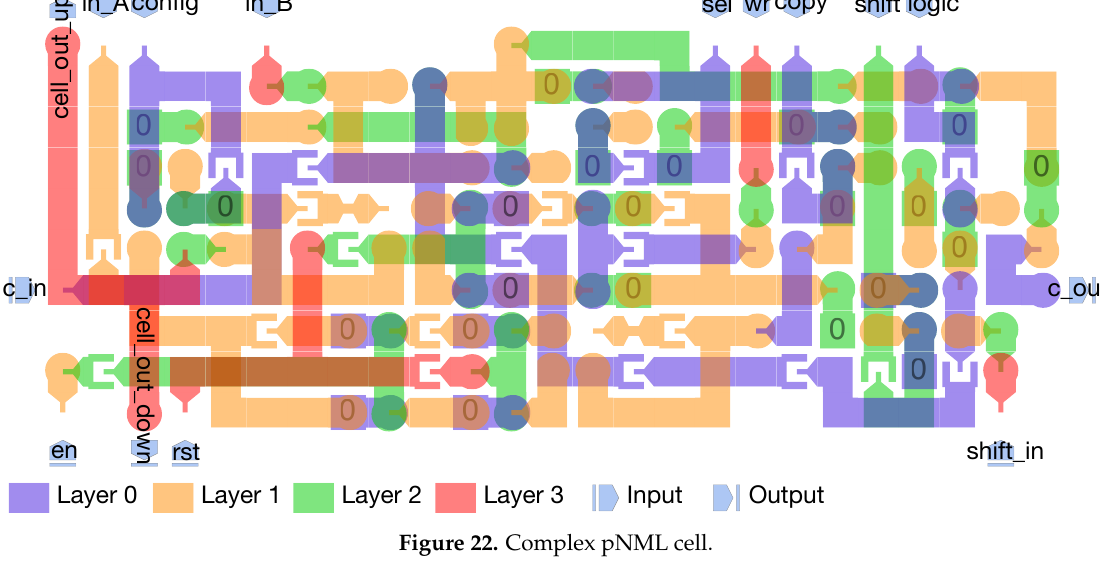
Figure 22. Complex pNML